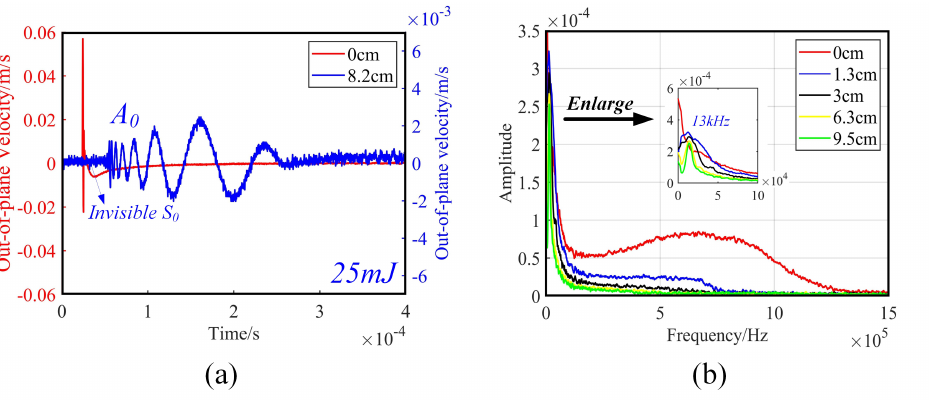
Figure 1. Time domain ( t -domain) and frequency domain ( f -domain) characteristics of laser ultrasonic Lamb wave. ( a ) Response signals at 0 and 8.2 cm from the excitation source. ( b ) Frequency spectrum of the response signal at 0 to 9.5 cm from the excitation